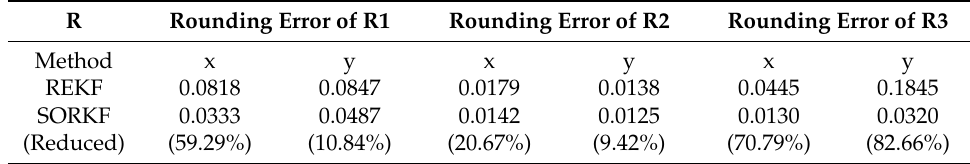
Table 3. Rounding error of trajectory estimation in fixed-formation multi-robot